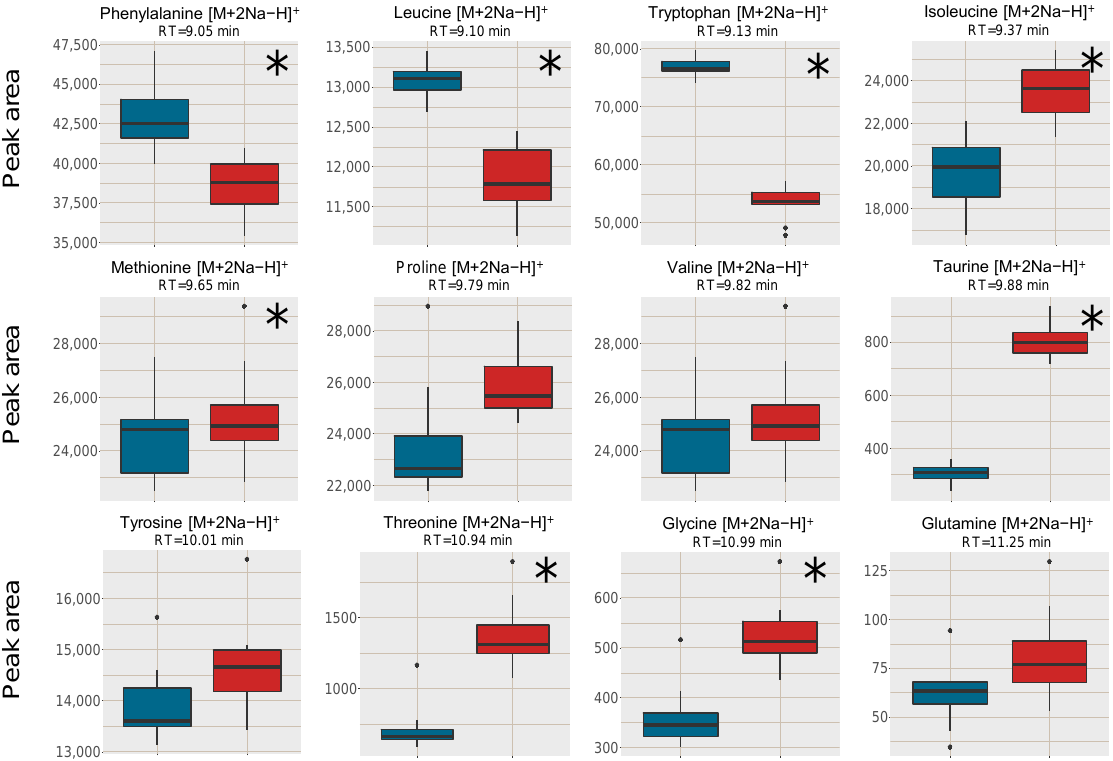
Figure 4. Box plots of the peak area of [M+2Na − H] + of amino acids in human blood plasma samples, red box = SPE MCX, blue box = PPT. The outer edges of the boxes represent the first and third quartiles respectively while the middle line represent the median and outliers are denoted by dots in the plots. Analytes with statistically different peak area ( p < 0.05 in a unpaired t -test with bonferroni correction applied) between the two sample treatments are marked with a * in the top right corner of each individual box-plot.